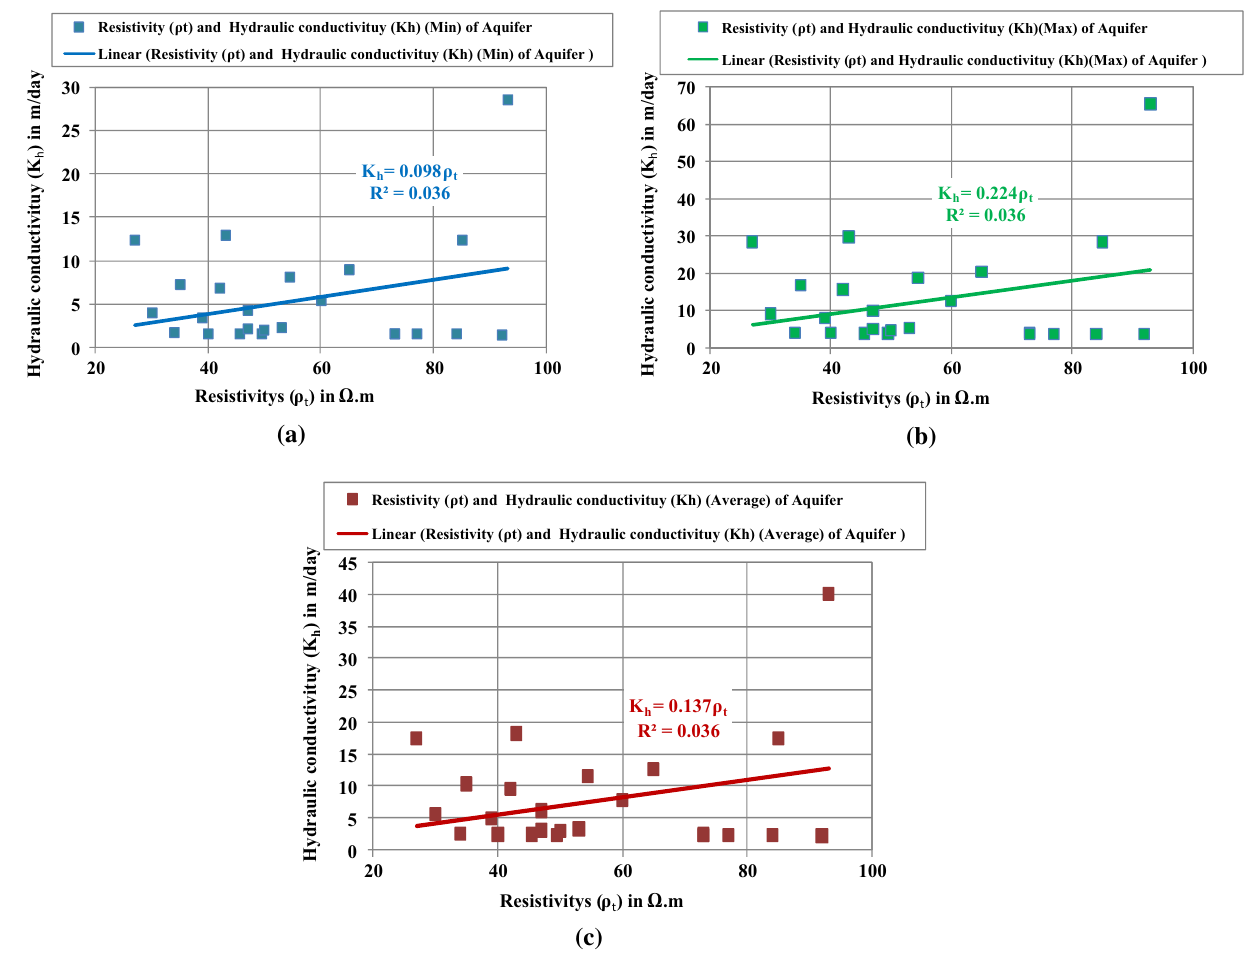
Fig. 11 Relationship between the resistivity ( ρ K t ) in Ω m and the minimum hydraulic conductivity ( h ) in m/day of the aquifer ( a ), the maximum hydraulic conductivity ( K h ) in m/day of the aquifer ( b ) and the average hydraulic conductivity ( K h ) in m/day of the aquifer ( c